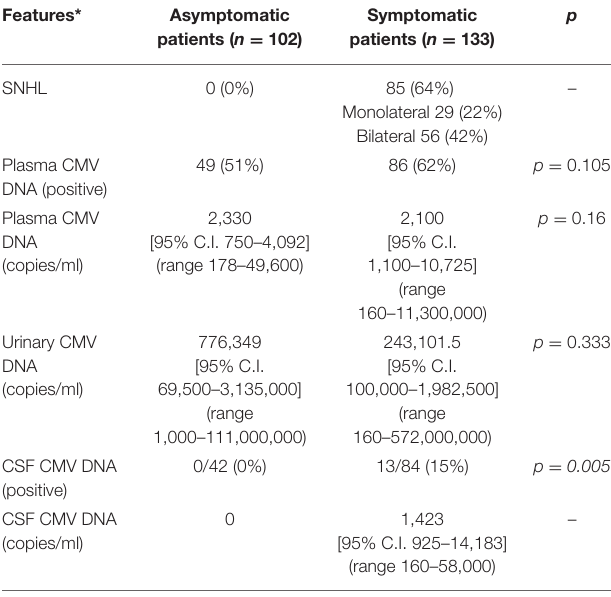
TABLE 4 | SNHL and laboratory features at onset in patients with cCMV